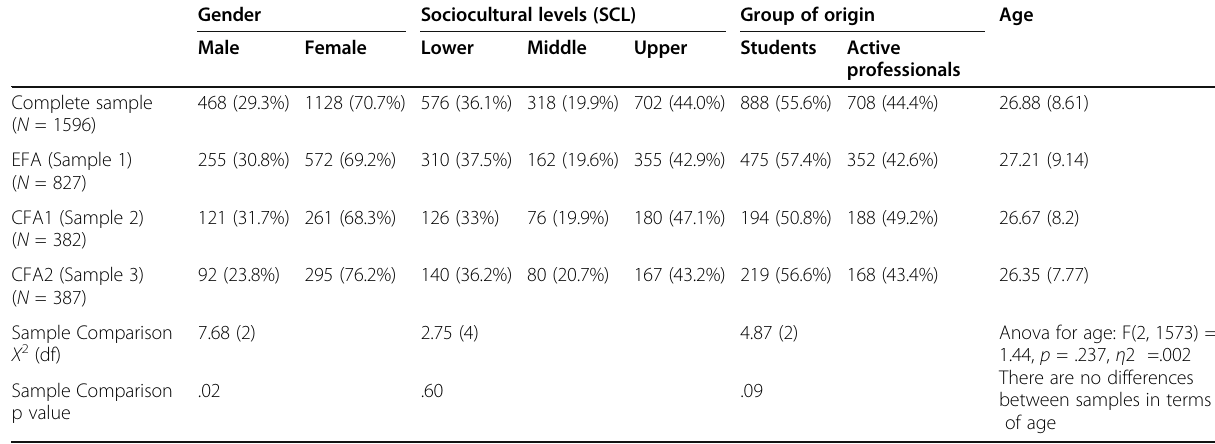
Table 1 Demographic characteristics by sample Gender Sociocultural levels (SCL) Group of origin Age Male Female Lower Middle Upper Students Active